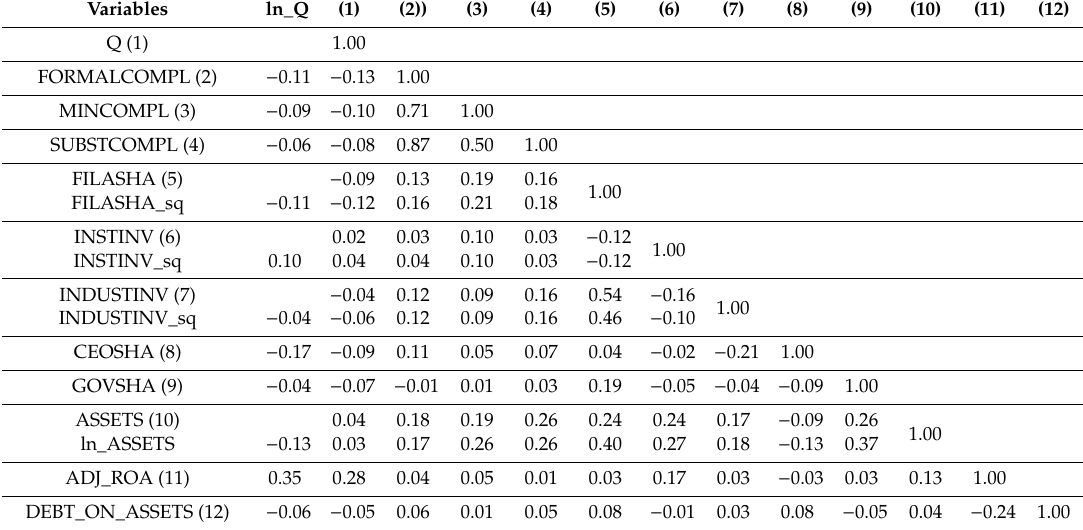
Table 9. Correlation coe ffi cients of variables, regressand and